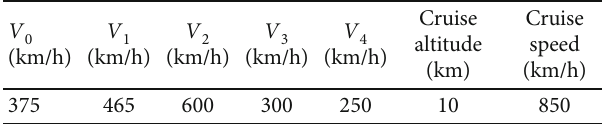
Table 6: Aircraft ECS data.